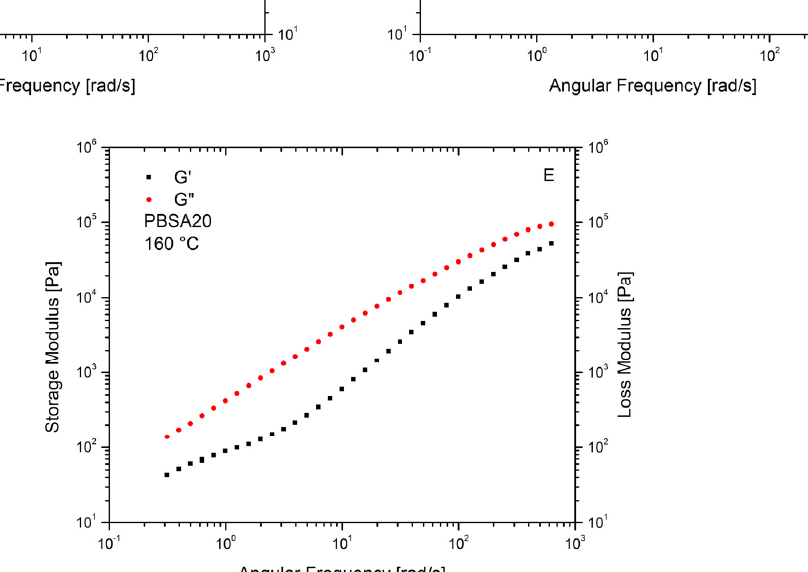
Figure 6. Storage G (cid:48) ( (cid:4) ) and Loss G (cid:48)(cid:48) ( • ) moduli vs. frequency of PBSA and PBSA/BC composites Figure 6. Storage G’ ( ■ ) and Loss G” ( • ) moduli vs. frequency of PBSA and PBSA/BC composites at at 160 ◦ C. PBSA ( A ), PBSA5 ( B ), PBSA10 ( C ), PBSA15 ( D ), PBSA20 ( E 160 °C. PBSA ( A ), PBSA5 ( B ), PBSA10 ( C ), PBSA15 ( D ), PBSA20 ( E ).